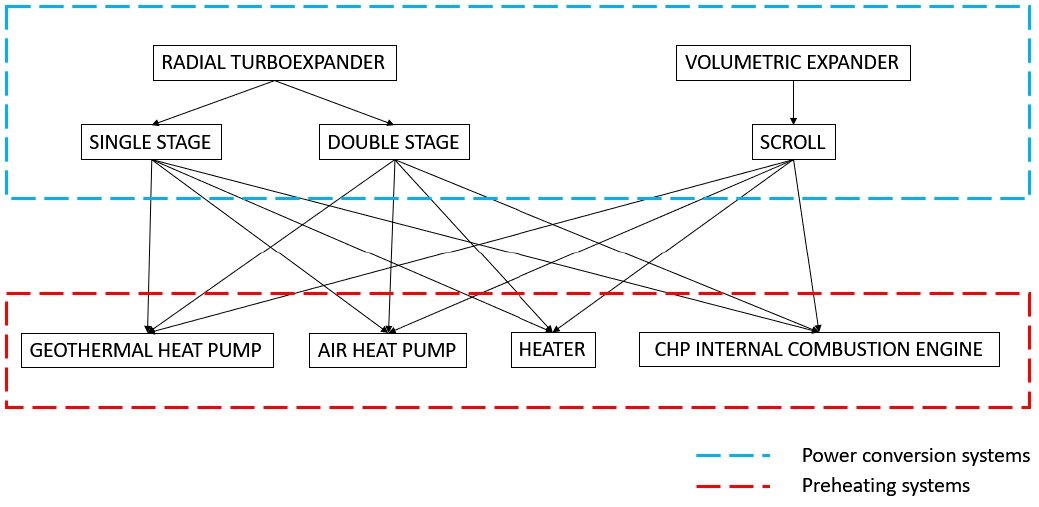
Figure 4. All possible combinations (12) among the expansion technologies and natural gas preheating systems considered in the analysis.